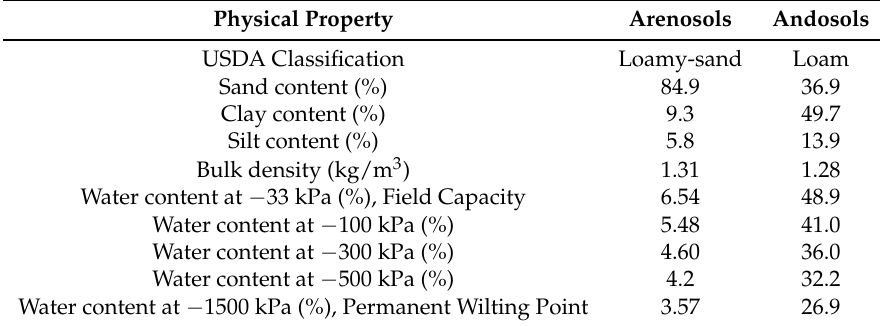
Table 1. Physical soil properties following the procedures described in [29]. Water content is given as percentage of dry